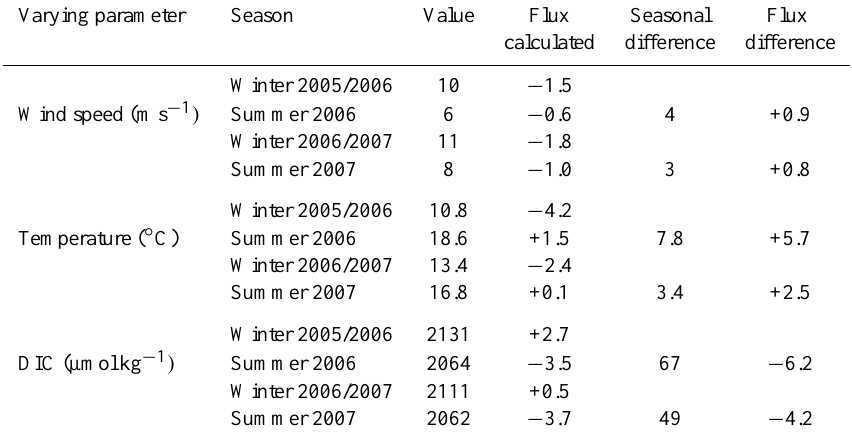
Table 3. Effect of varying wind speed (ms − 1 ), temperature ( ◦ C) and DIC concentration (µmolkg − 1 ) on the air-sea CO 2 flux calculation in mmolm − 2 d − 1 . Fluxes were calculated according to Eq. 3. The oceanic p CO 2 values were calculated from DIC, TA, salinity, and temperature data using the CO 2 SYS program. The calculation considered only one varying parameter at a time while all other parameters were considered constant: TA = 2350µmolkg − 1 ; S = 35; T = 16; wind speed = 8ms − 1 ; DIC = 2100µmolkg − 1 ; and atmospheric p CO 2 = 380µatm. Varying parameter Season Value Flux Seasonal